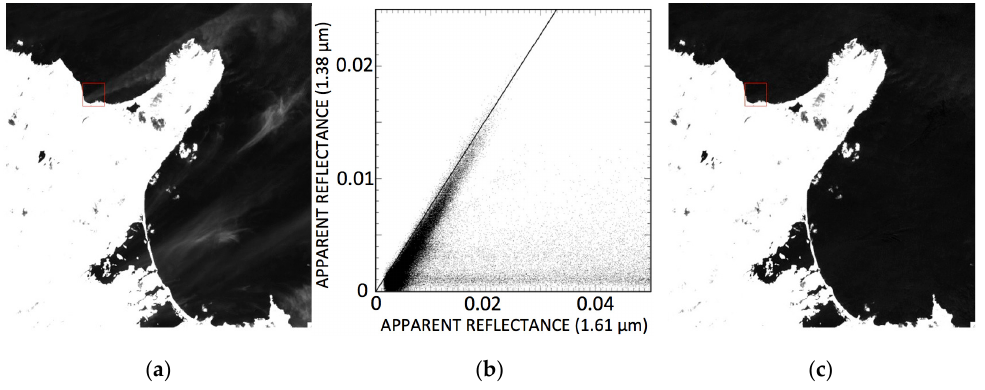
Figure 5. ( a ) A Landsat 8 OLI SWIR1 image acquired over Cape Breton Island in eastern Canada (northeast to Halifax) on 16 September 2014; ( b ) The scatter plot of Band 9 (cirrus) versus SWIR1 band; ( c ) The cirrus-corrected SWIR1